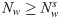
Successive stages of a solid thrombus formation.a—thrombus nucleation, b—formation of fibre-like fibrin structure, c—fibre-like structure thickening, d—solid thrombus. Shown are the color maps of N
w—the weight-average number of monomers in fibrin-polymer in the vessel, with red areas representing regions of fibrin gel formation (Nw≥Nws). Streamlines are plotted to visualize the flow, and the separatrix, which divides the core of the flow from the recirculation zone, is shown with a dashed line. Parameters used in the simulations are: Re = 130, h = 0.5, d~=0.5, μ~2=9.5. Note that only a fragment of the vessel closest to the plaque is depicted.